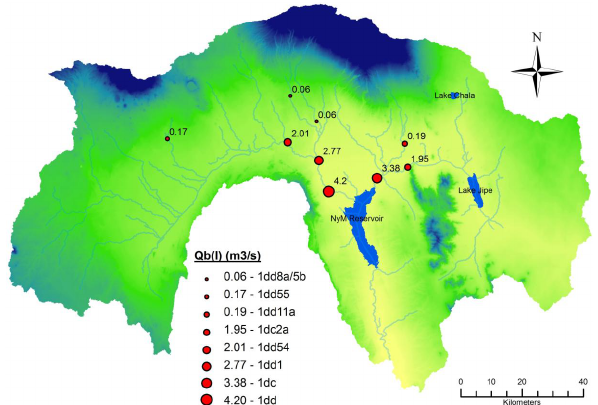
Figure 10. Total net irrigation water use ( Q b ( I ) ) estimated upstream of the gauge stations using a modified STREAM model in the upper Pangani River basin (averaged over the years